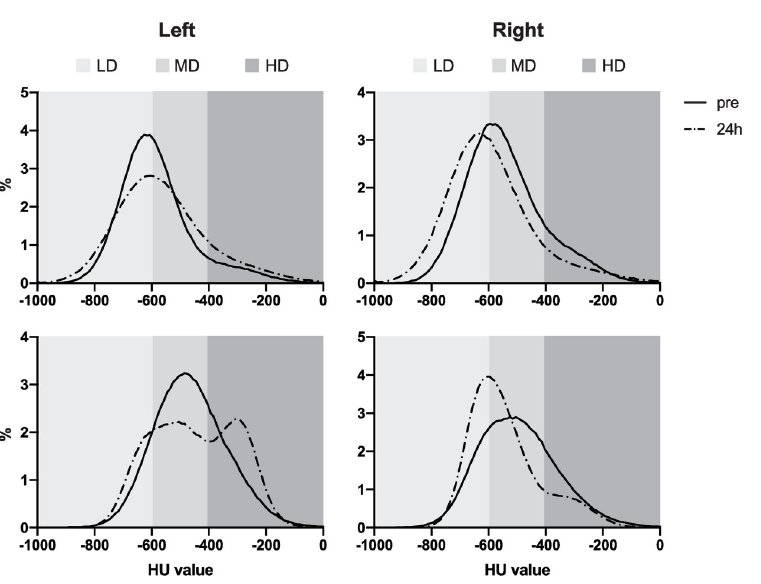
Fig 5. Histograms representing the relative lung density pattern of the left and right lung of SARS-CoV-2 infected macaques.